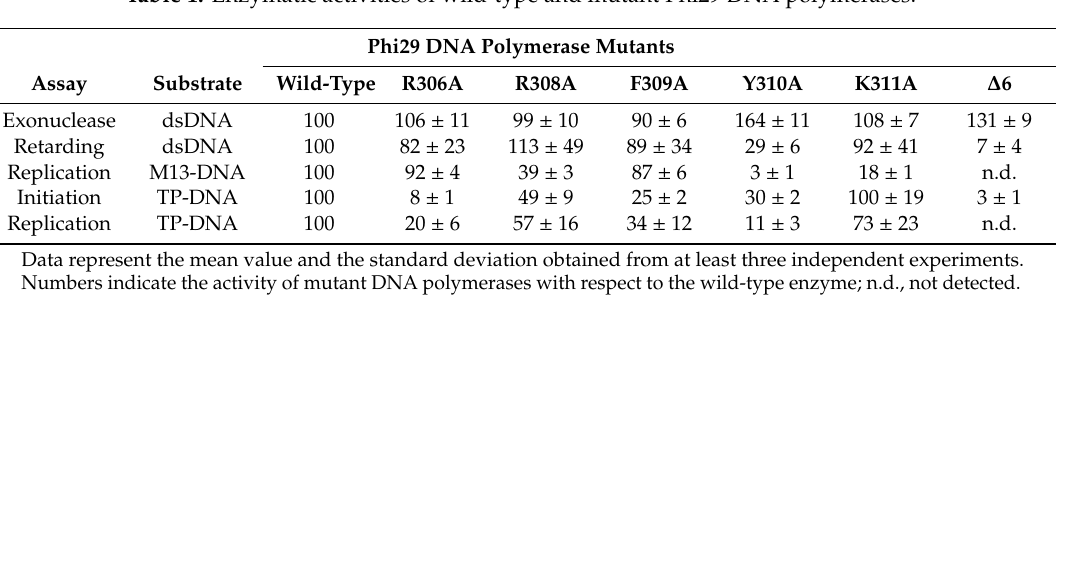
Figure 3. The 3’–5’ exonuclease activity of Phi29 DNA polymerase mutants. The assay was performed as described in Materials and Methods, using the 5’-labeled primer / template molecule 15mer / 21mer depicted on top of the figure. After incubation for the indicated times at 25 ◦ C, degradation of the labeled DNA was analyzed by electrophoresis in 7M urea-20% polyacrylamide gels and autoradiography. The position of the 4mer degradation intermediate of the sp1 substrate (15mer) is indicated. Asterisk indicates the 5’- 32 P-labeled end of the primer strand. c: control DNA. Table 1. Enzymatic activities of wild-type and mutant Phi29 DNA